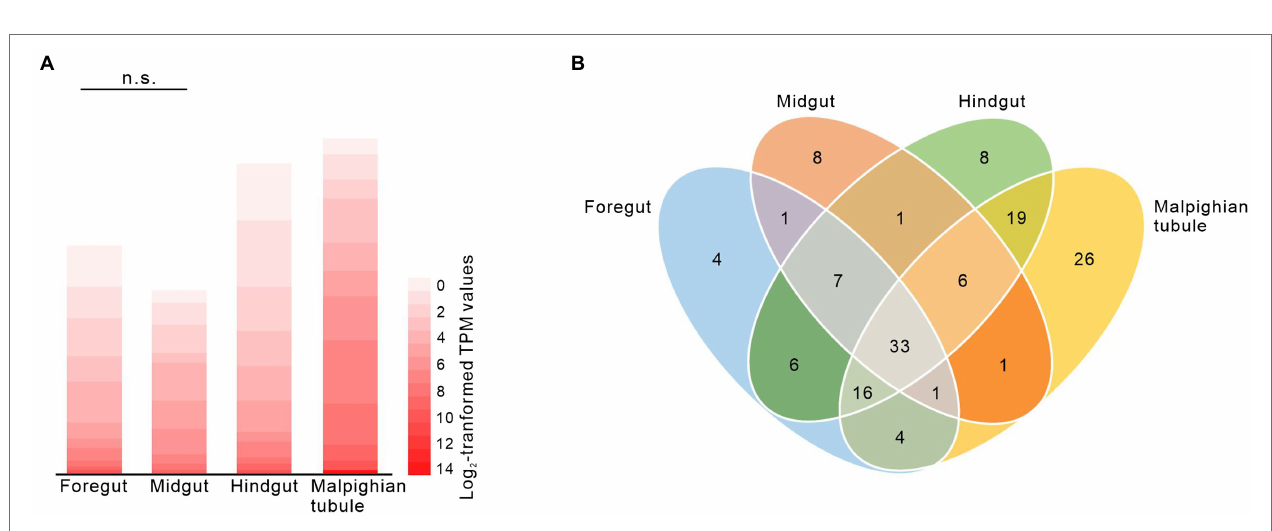
FIGURE 3 | Expression of putative major facilitator superfamily (MFS) genes in the foregut, midgut, hindgut, and Malpighian tubules of adult Phyllotreta armoraciae shown by heatmap (A) and Venn diagram (B) . Expression of 141 putative MFS genes [TPM (transcripts per million) > 1] was analyzed by RNA-sequencing (Yang et al., 2021). Each value represents the mean of four biological replicates ( Supplementary Data 1 ). The overall expression levels of putative MFS genes in foregut and midgut were compared by Mann–Whitney U -test. n.s., not significantly